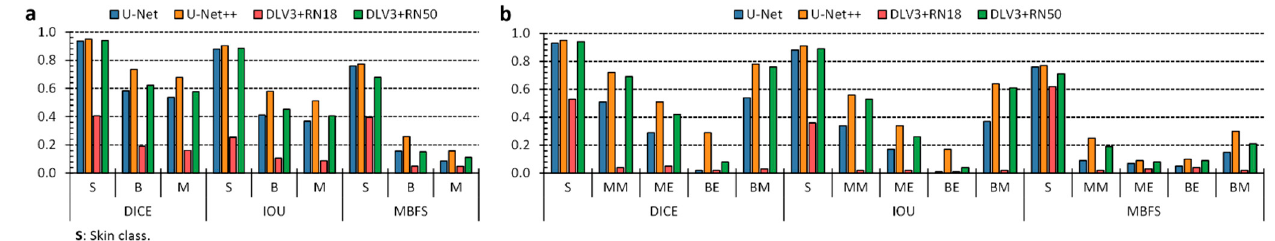
Figure 4. Performance of the epidermal lesion segmentation. ( a ) and ( b ), Binary and multilabel seg- mentation performance of the four different approaches, respectively. The acronyms have the following meanings: Skin (S), Benign (B), Malignant (M), Benign Epithelial (BE), Benign Melanocytic (BM), Malignant Epithelial (ME), and Malignant Melanocytic (MM).